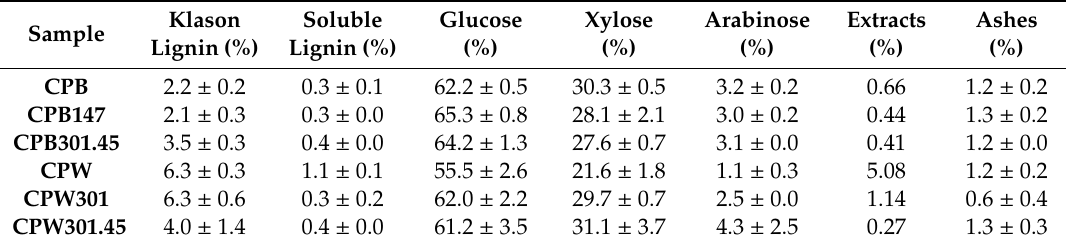
Table 1. Composition of the cellulose pulp